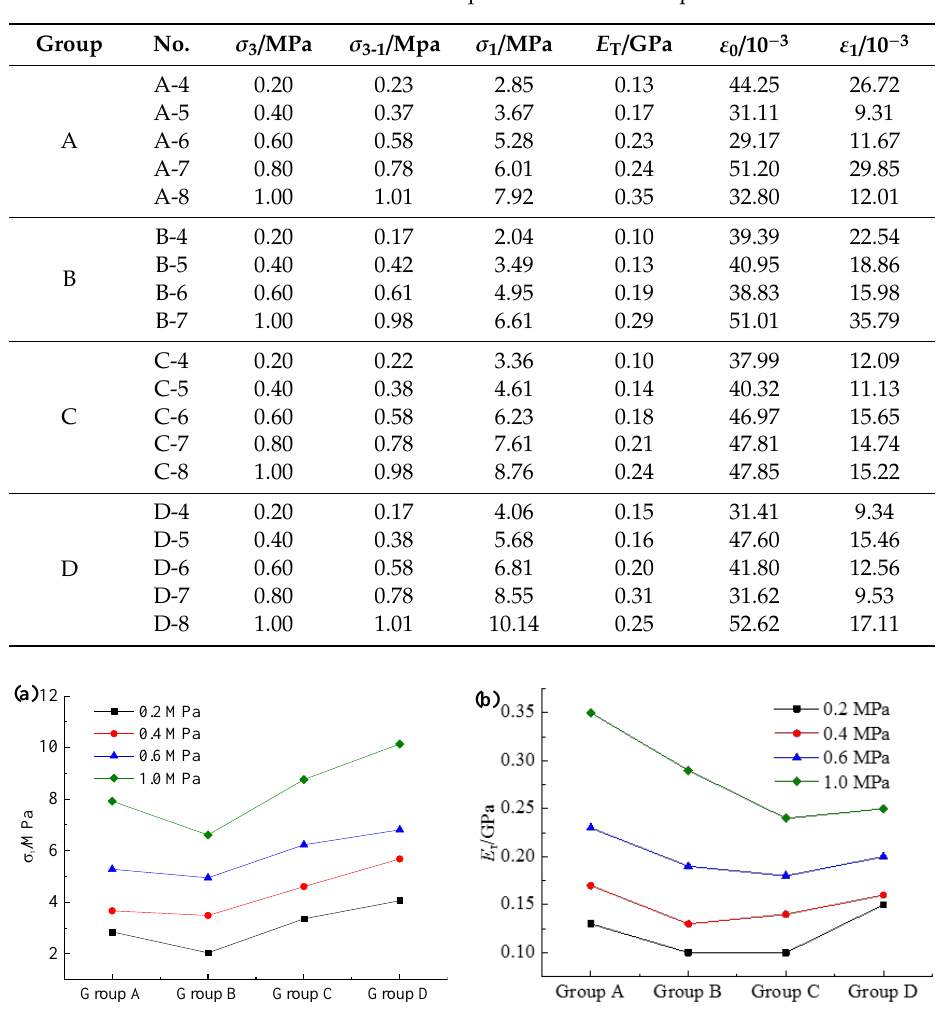
Figure 7. Test results concerning variations of triaxial compression with particle size: ( a ) peak strength and ( b ) elastic modulus.